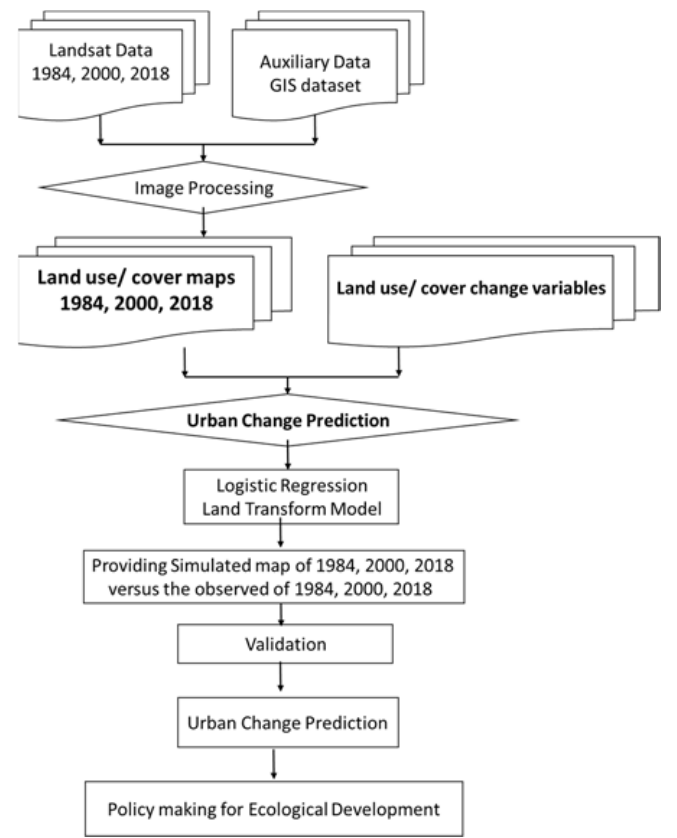
Figure 2. Flow chart of the presented methodology.